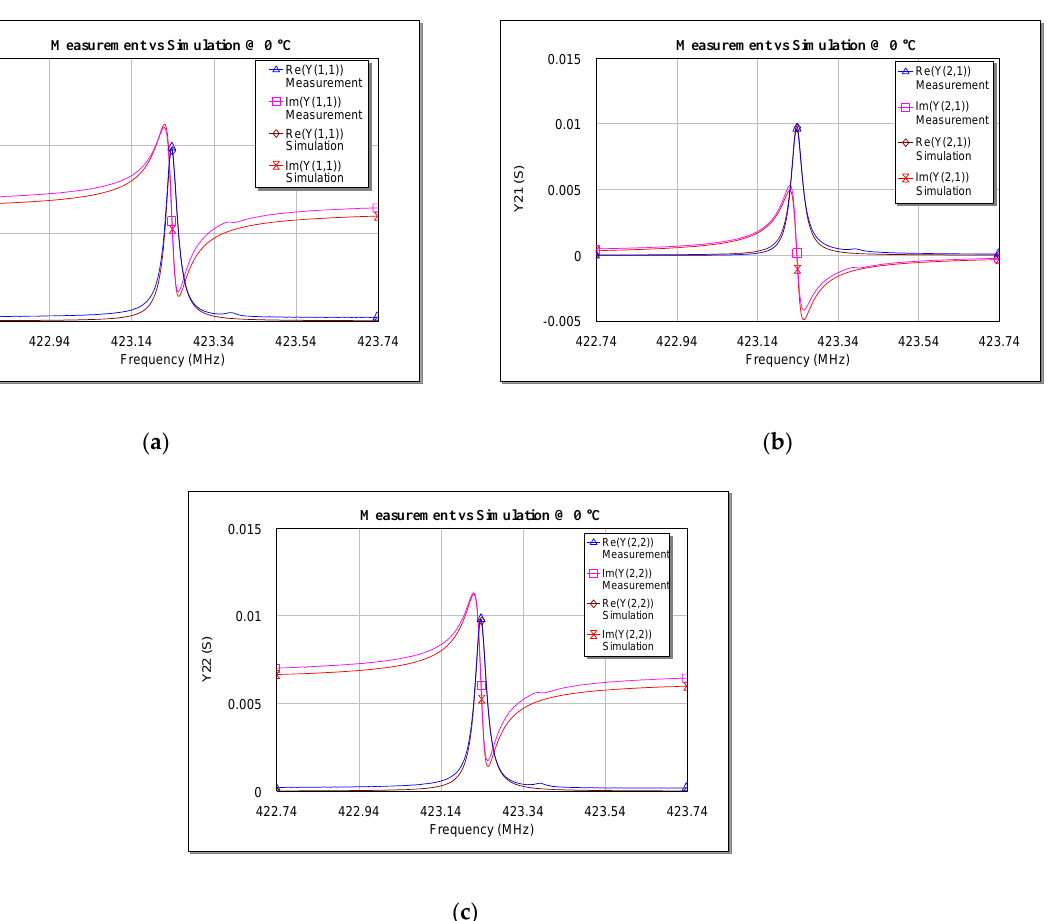
Figure 9. Comparison between measurements and simulations of the real and imaginary parts of ( a ) Y 11 , ( b ) Y 21 , and ( c ) Y 22 versus the frequency for the tested SAW resonator at 0 °C.